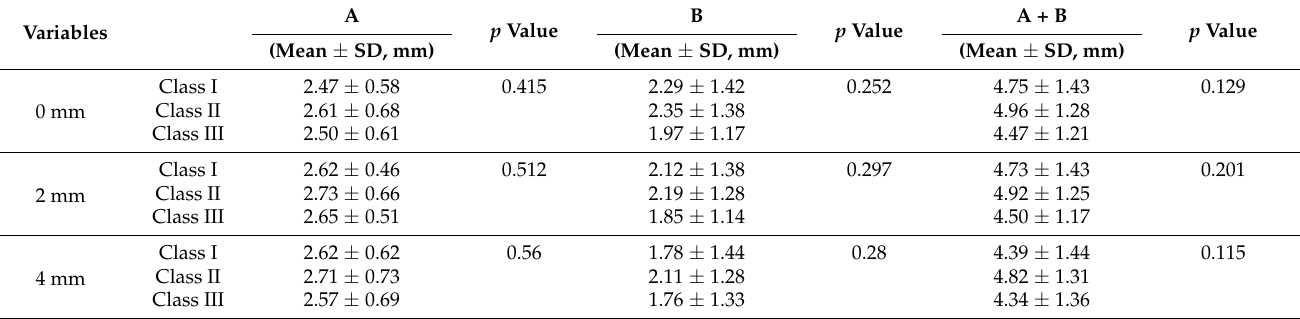
Table 2. From the base plane (0 mm) to 40 mm forward, the thickness (mm, mean ± SD) of buccal cortical bone and marrow with their skeletal patterns in the One-way ANOVA with post hoc Tukey HSD test.